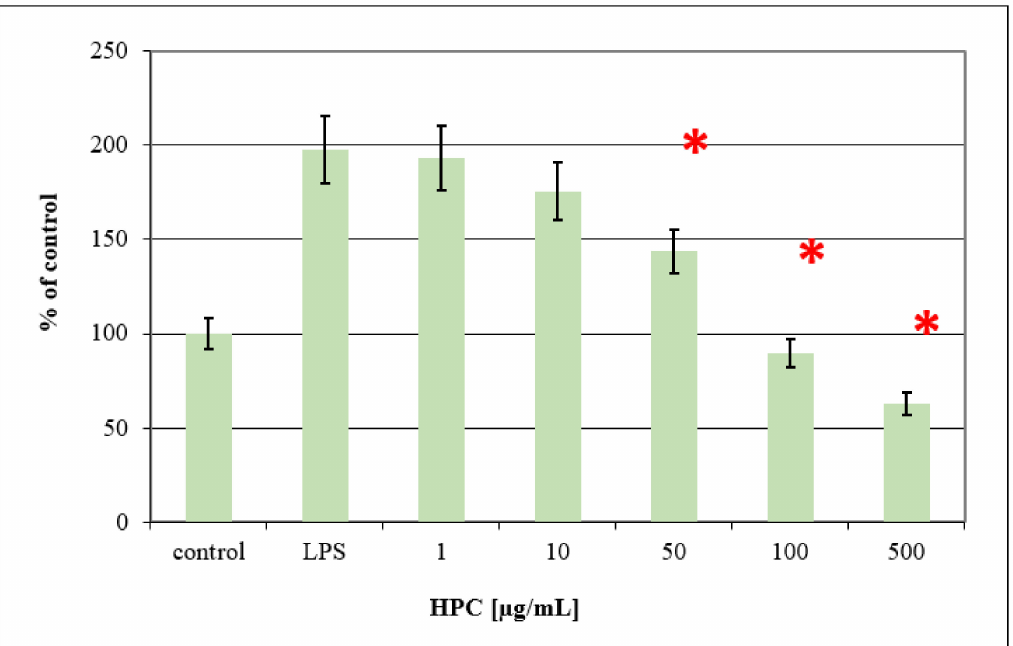
Figure 4. Dose-dependent inhibition of LPS mediated production of Nitric oxide (NO) in LPS-treated THP-1 cells by anti-hemorrhoidal polyherbal cream (HPC). For each concentration treatment, the level of NO release is represented as a percentage of the control set at 100%. Values represent means ± SD (* p < 0.05 significant as compared to LPS alone) of three independent experiments carried out in